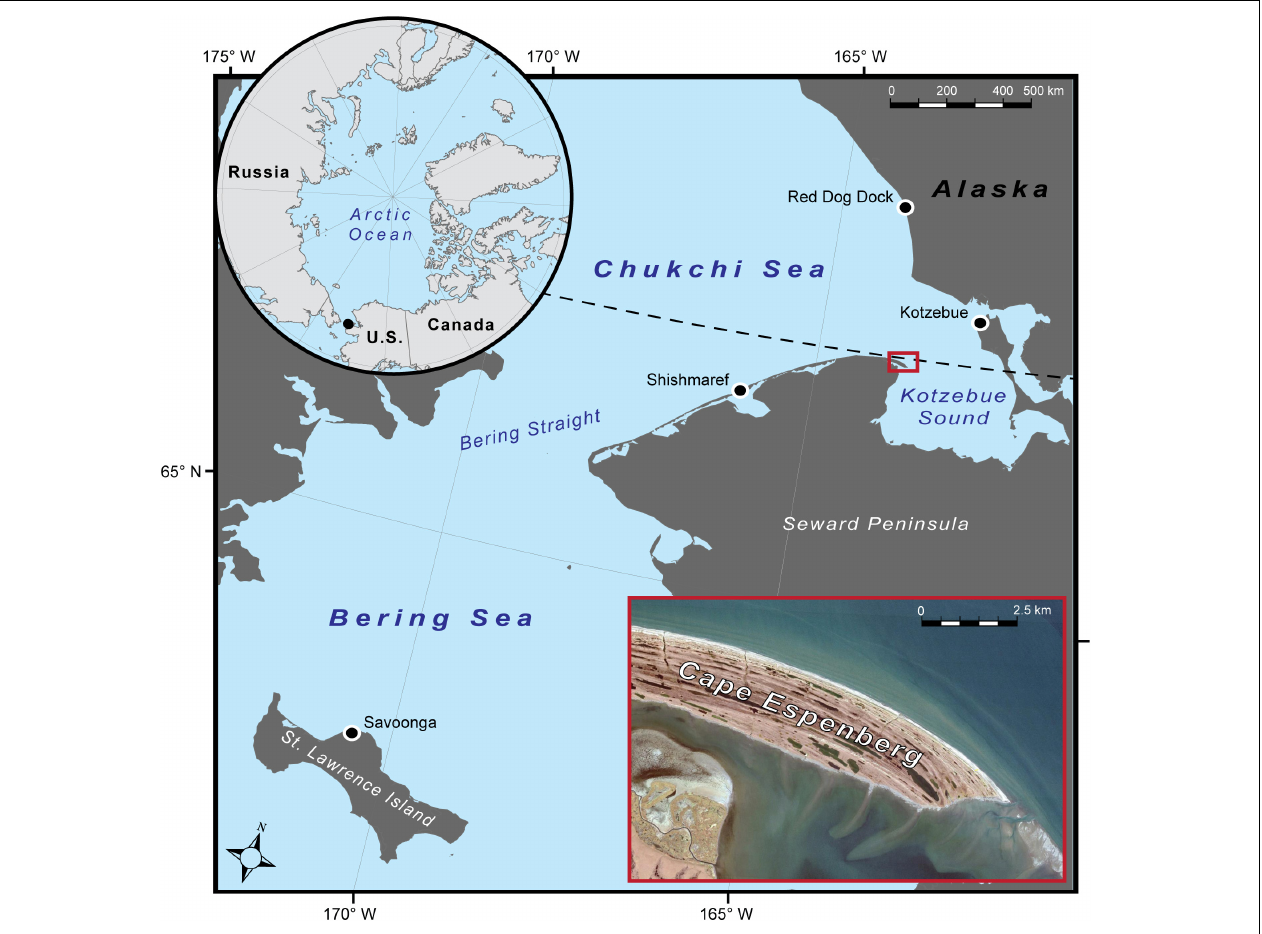
FIGURE 2 | Map showing the Cape Espenberg barrier spit. The Cape is located along the Arctic Circle (dashed line) on the northern tip of the Seward Peninsula, Alaska (red box), within Kotzebue